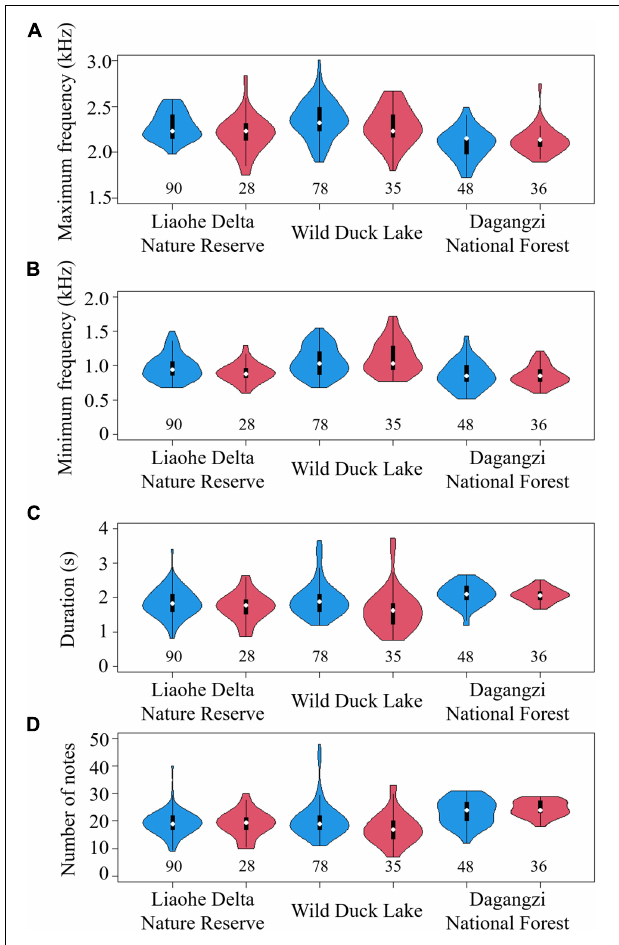
FIGURE 2 | Call characteristics between periods and among areas: maximum frequency (A) , minimum frequency (B) , duration (C) , and number of notes (D) . The blue violins indicate calls recorded before 12:00; the red violins indicate calls recorded after 12:00. Sample sizes are shown below each violin. In the middle of each density curve is a box plot, with black rectangle showing the ends of the first and third quartiles and white dot the median.